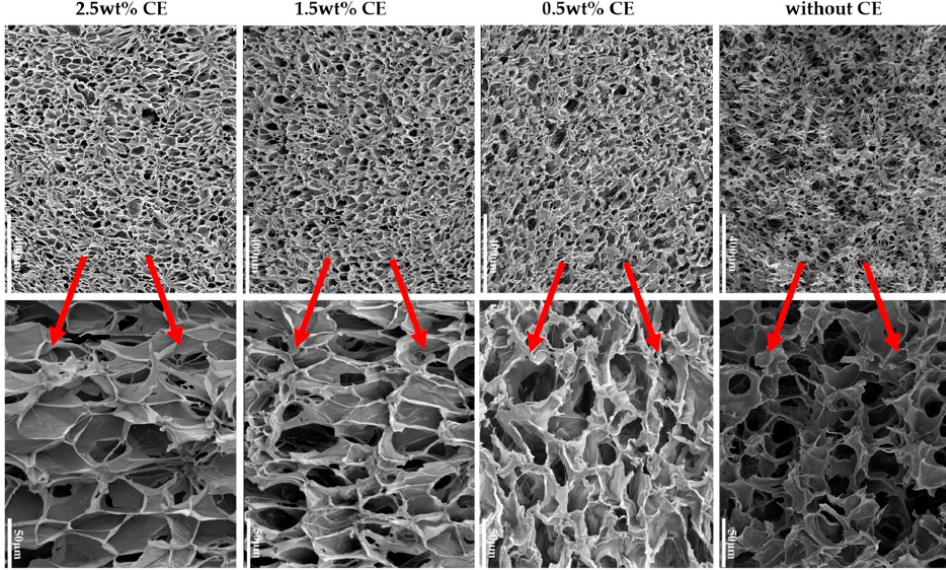
Figure 16. SEM micrographs of the polylactide/wood flour composite foams and the corresponding cell size distribution in the presence of various CE concentrations. Reprinted from Wang et al. [130].